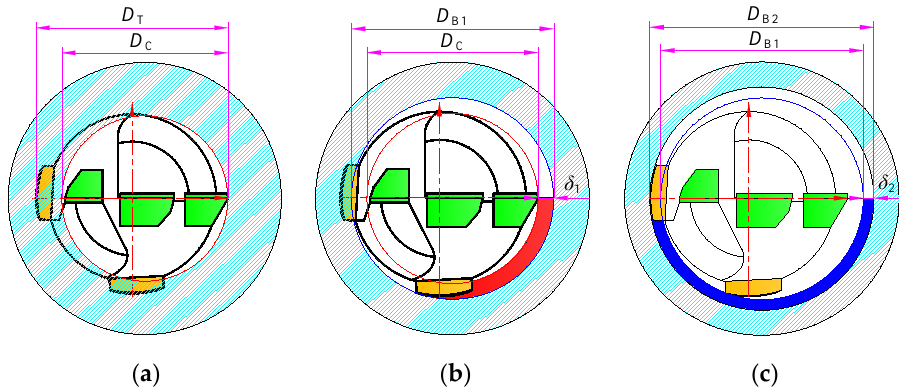
Figure 2. Self-guided hole forming process for BTA deep hole drilling: ( a ) hole formed by tooth cutting; ( b ) hole formed by extrusion of first guide pad; ( c ) hole formed by extrusion of second guide pad.